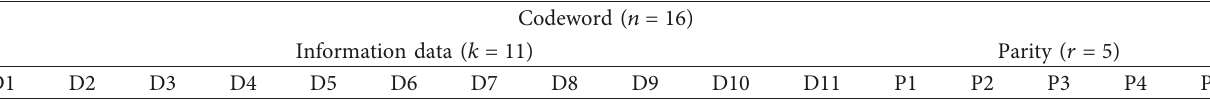
Table 6: Construction of the Hamming [16, 11, 4] codeword.